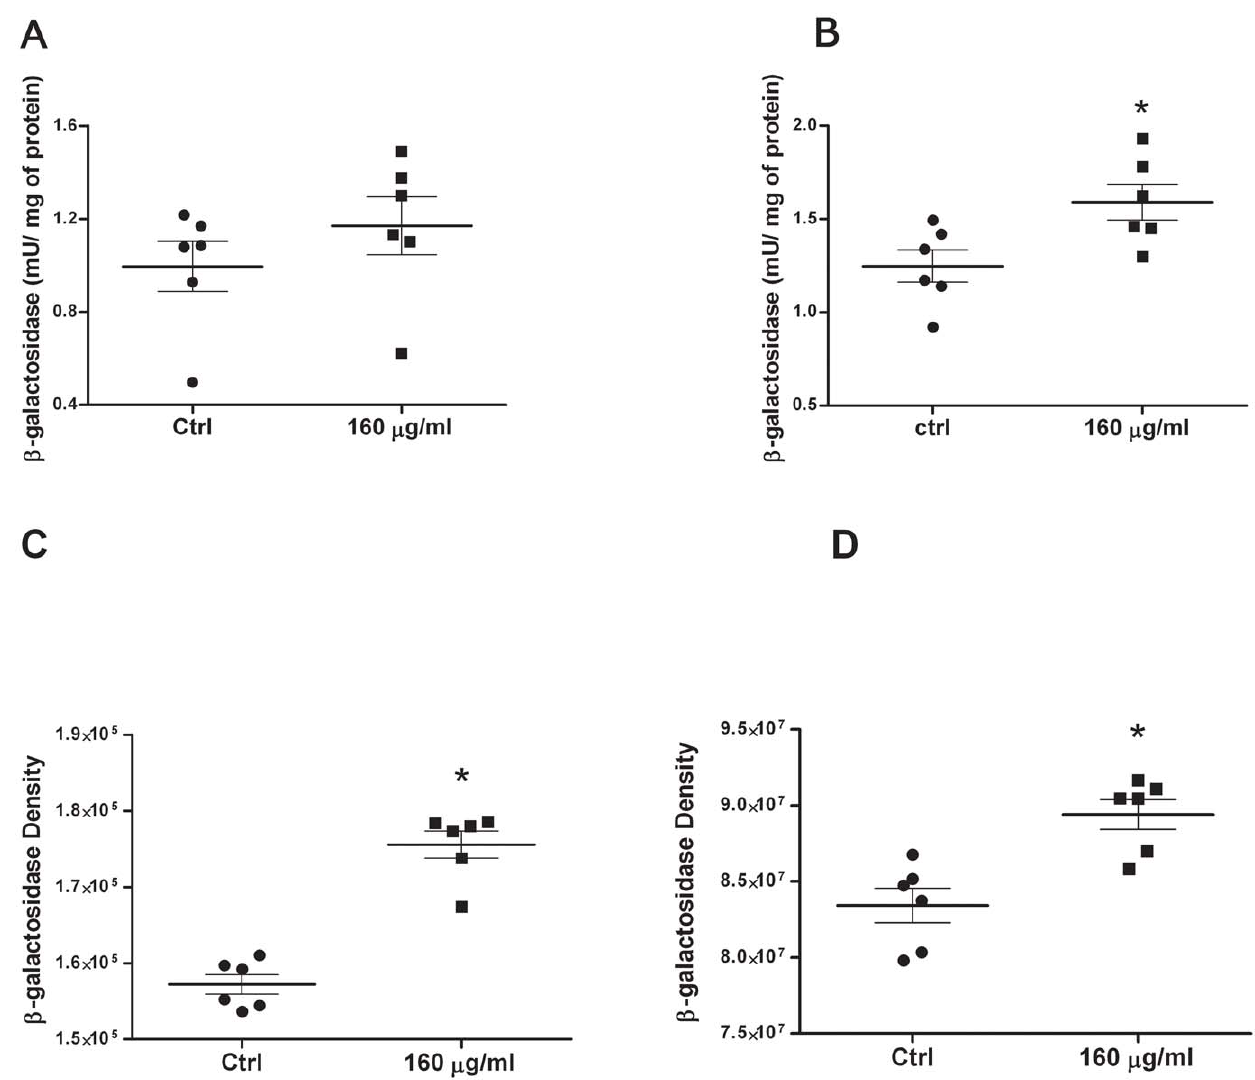
Figure 5. Invivo transfection efficiency after a single dose nebulisation in CD1 mice. RTN suspension (6 ml), at a concentration of 160 m g/ ml of DNA, was nebulised using the AeroEclipse II BAN in a plexiglass box containing 6 CD1 mice. After 48 h following the nebulisation, the animals were culled and the lungs and the tracheas removed. In the harvested tissues, the levels of b -galactosidase were measured by quantifying the enzymatic activity and by immunodetecting the protein. Control animals were nebulised with the same clinical grade H 2 O in which nanocomplexes were made. A and B Determination of b -galactosidase enzymatic activity: The b -galactosidase activity was measured by CPRG assay in both whole lung lysates (A) and in those from the tracheas (B). The activity of enzyme (mU) in the lysates was calculated against the b -galactosidase activity of Escherichia coli and normalised for the total protein content. (*) in panel B (tracheas) indicates statistically significant difference (Mann- Whitney test) at 0.05 level (p , 0.05). No difference was found in panel A, although there the protein activity showed a similar trend. C and D Detection of b -galactosidase protein: The lysates from the whole lungs (C) and the trachea (D) from each mouse were spotted onto PVDF membranes. Dot blots were first probed with goat polyclonal anti- b -galactosidase antibody and then with horseradish peroxidase-labelled rabbit polyclonal anti-goat immunoglobulin. The quantification of duplicate dots per each mouse is shown. The difference between the control group (nebulised with water) and the cohort which received RTNs formed using pCpG-free lacZ reporter gene, was statistically significant at the Mann- Whitney test (*, p , 0.05). Pre-nebulisation samples (PN), the leftover (LO) in the nebuliser samples, collected from the throat and the different stages of the